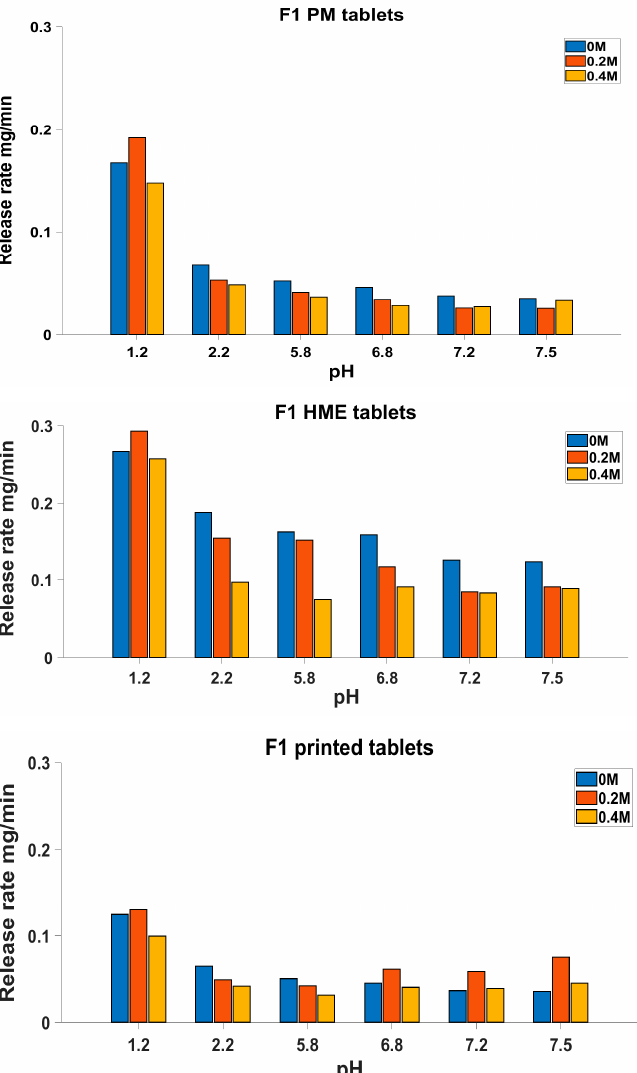
Figure 5. Release rate in each pH medium during dissolution test at different ionic strength additions for F1.